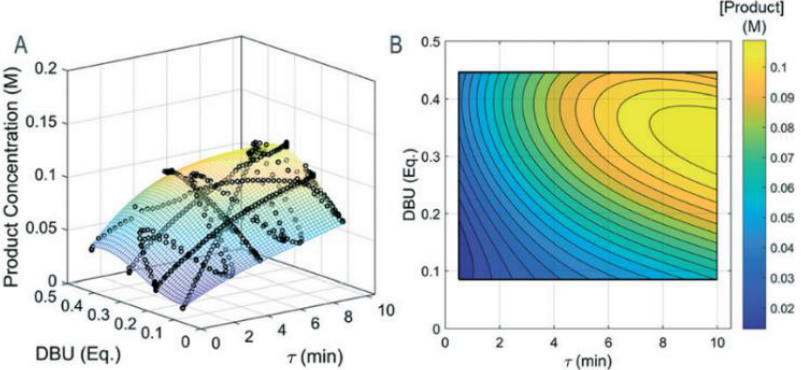
Figure 4. Flow synthesis design spaces of a Knoevenagel condensation in flow as ( A ) 3D projection with experimental data points, ( B ) 2D projection. Reproduced with permission from Wyvratt et al., Reaction Chemistry & Engineering; published by Royal Society of Chemistry, 2019 [55].